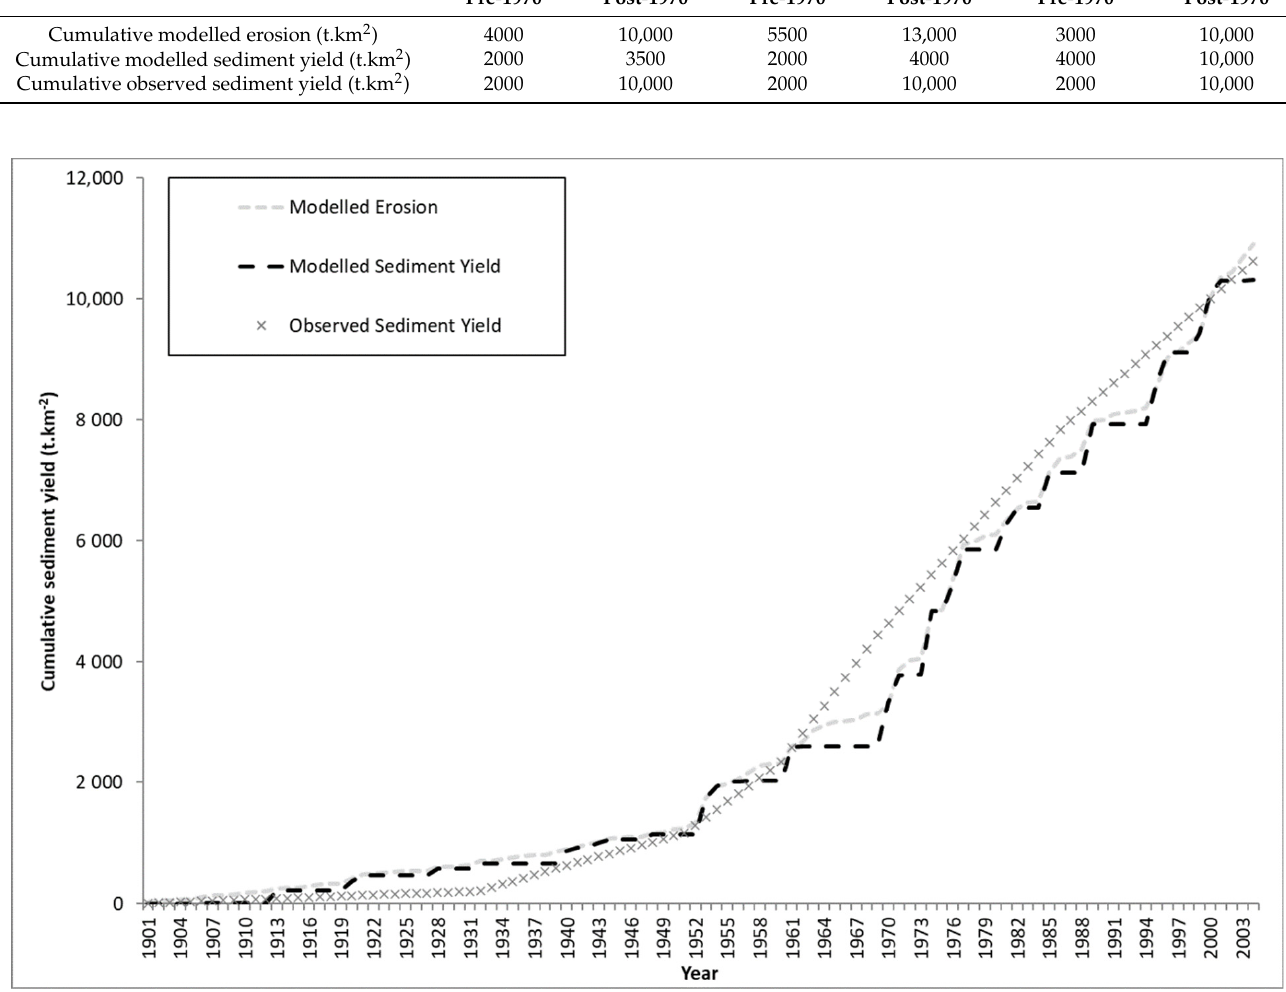
Figure 7. A comparison of daily sediment yield and discharge outputs for the Cranemere catchment.